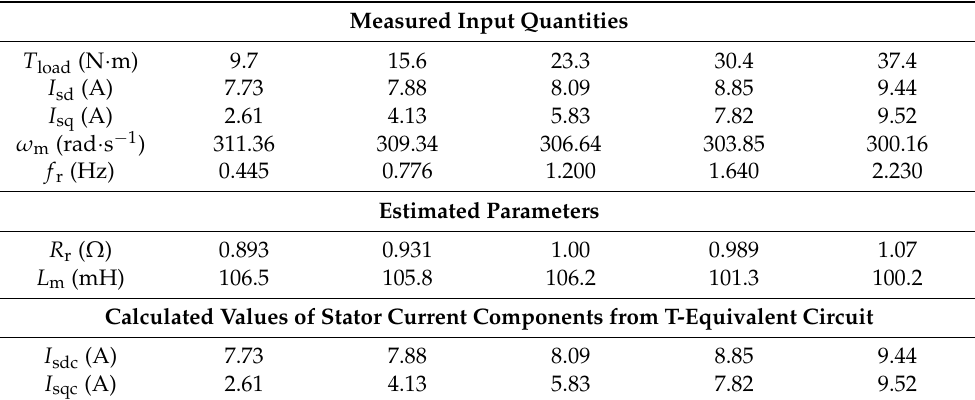
Table 6. Measurement at f s = 50 Hz ( ω s = 314.16 rad · s − 1 ) and V sq = 280 V.